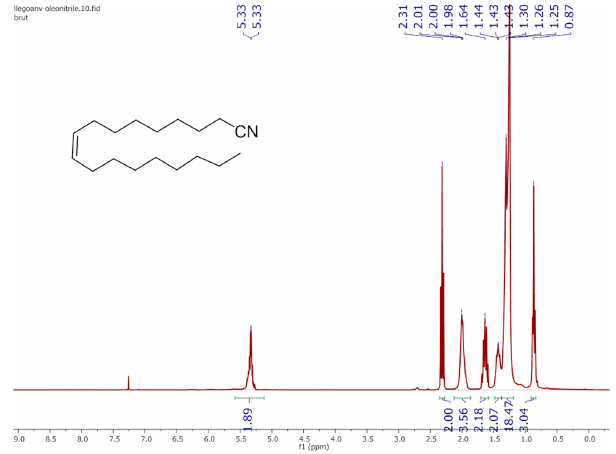
Figure A1. 1 H NMR spectrum (400 MHz, CDCl 3 , 298 K) of starting oleonitrile material furnished by Arkema Company.